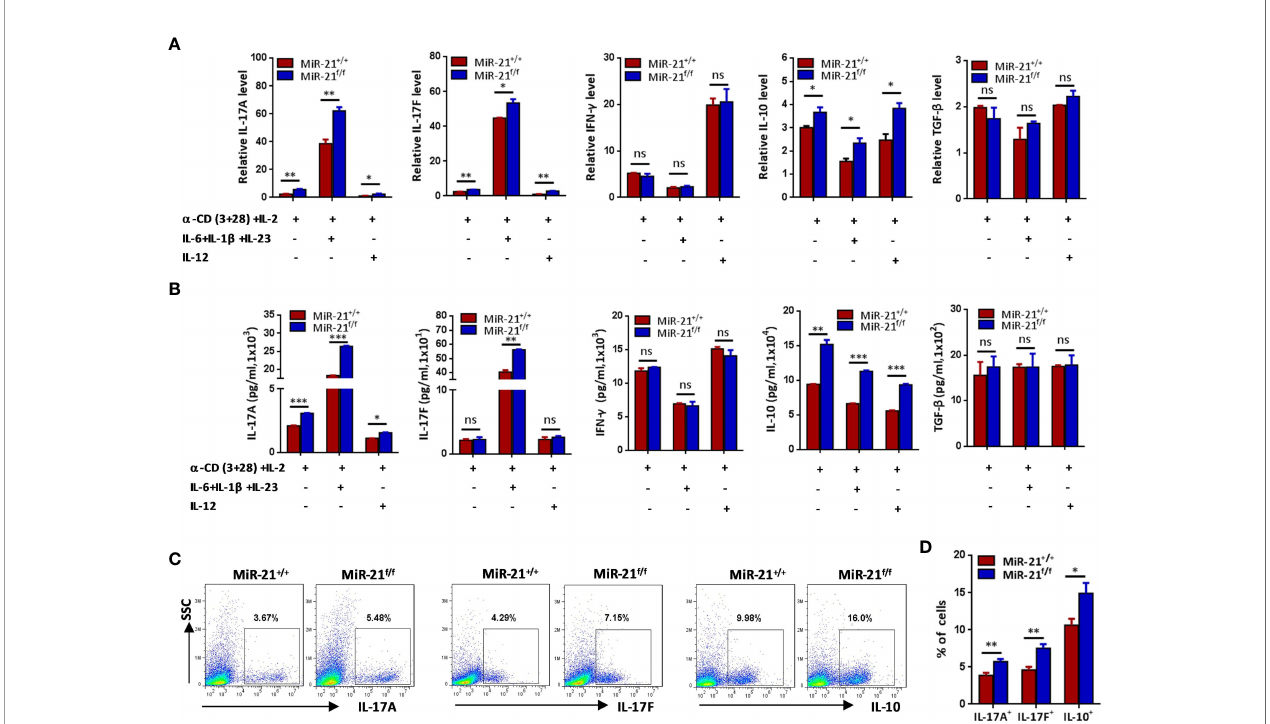
FIGURE 2 | Treg cells lacking miR-21 produce signi fi cant more IL-17 and IL-10 in vitro . CD4 + CD8 - YFP + cells were fl ow sorted from the spleen of Foxp3 Cre-YFP miR- 21 +/+ (MiR-21 +/+ ) and Foxp3 Cre-YFP miR-21 f/f (MiR-21 f/f ) mice (n=5). (A, B) Cells were stimulated with anti-CD3 plus anti-CD28 in the presence of indicated Th0, Th1 or Th17 priming cytokines. 48 h after stimulation, total RNA was extracted, and the mRNA expression of IL-17A, IL-17F, IFN- g , IL-10, and TGF- b was determined by quantitative RT-PCR (A) . In addition, culture supernatants were collected and the protein level of IL-17A, IL-17F, IFN- g , IL-10, and TGF- b was determined by ELISA (B) . (C, D) Cells were stimulated with anti-CD3 plus anti-CD28 in the presence of Th17 priming cytokines. After 72 h, cells were treated with PMA plus ionomycin in the presence of GolgiStop for 4 h. Cells were then fi xed, permeabilized, and stained with anti-Foxp3, anti – IL-17A, anti – IL-17F, anti – IL-10, and examined by fl ow cytometry (C) . The quanti fi cation of the percentages of IL-17A + , IL-17F + and IL-10 + cells among total live cells were shown in (D) . Data are representative of three independent experiments. ns, no signi fi cance. *p < 0.05, **p < 0.01, ***p <